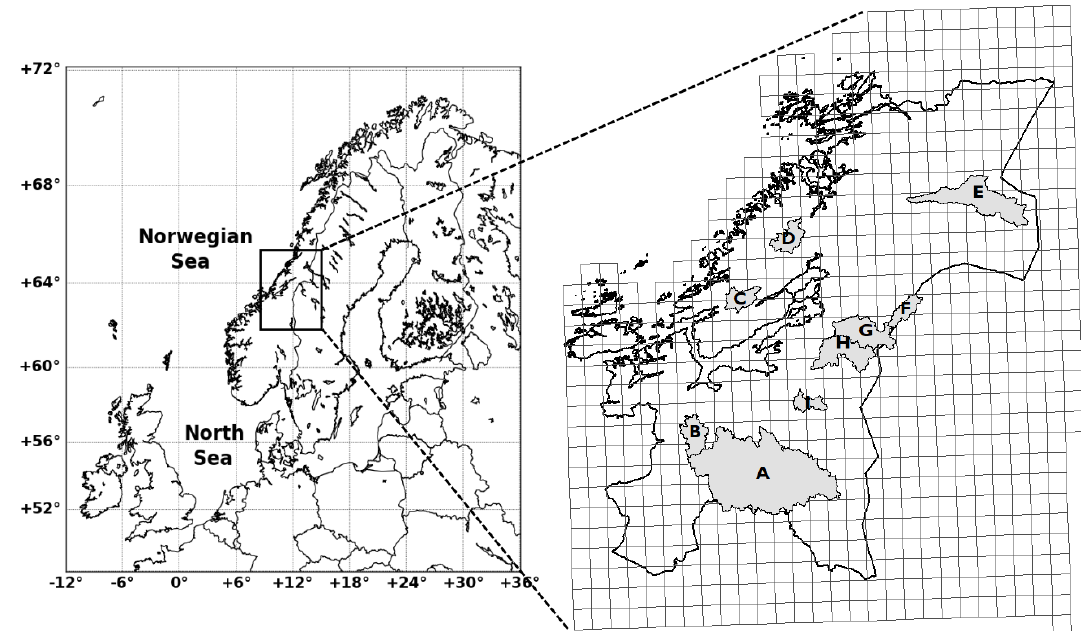
Figure 2. The study area is located in Trøndelag in central Norway, covering the entire Trøndelag and a small part of neighbouring Sweden, and consists of 695 RCM grid cells (rectangular-like polygons) and 109514 seNorge grid cells (within the polygons, not shown). For stochastic simulations of gridded daily precipitation, nine catchments within Trøndelag with catchment areas from 144 to 3084km 2 (shaded in grey) are used; see also Table